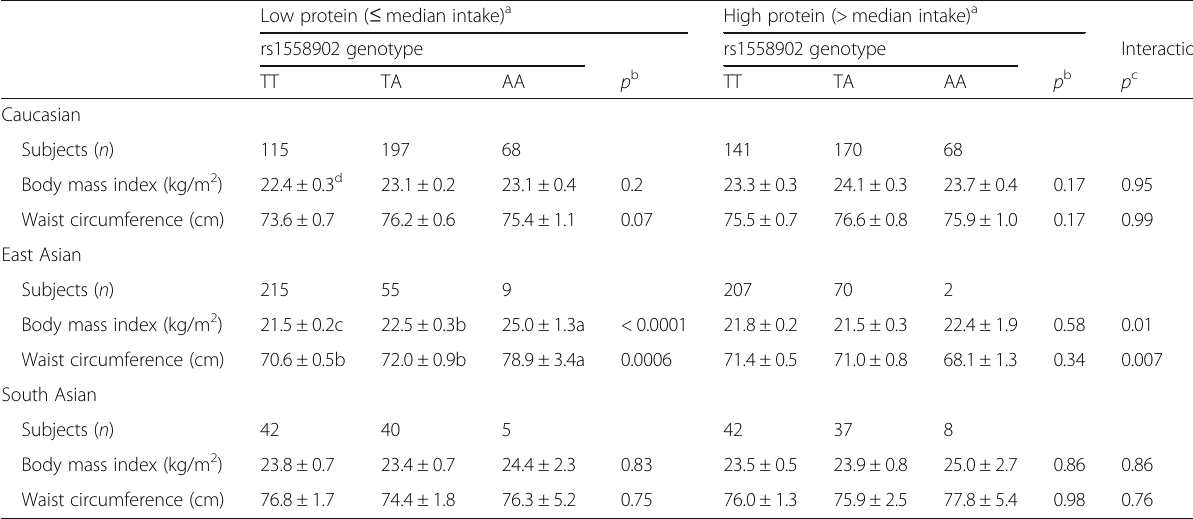
Table 3 FTO genotype and measures of body weight stratified by ethnicity and protein